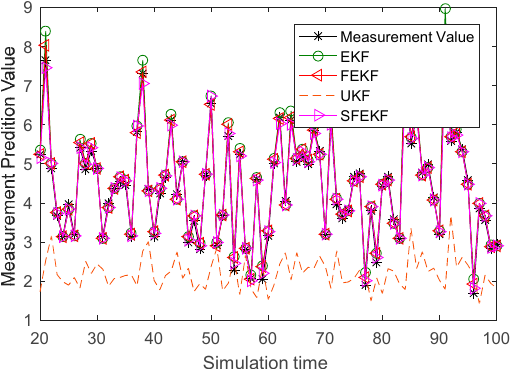
Figure 4. The measurement prediction curves of the four methods and the actual observation curve.